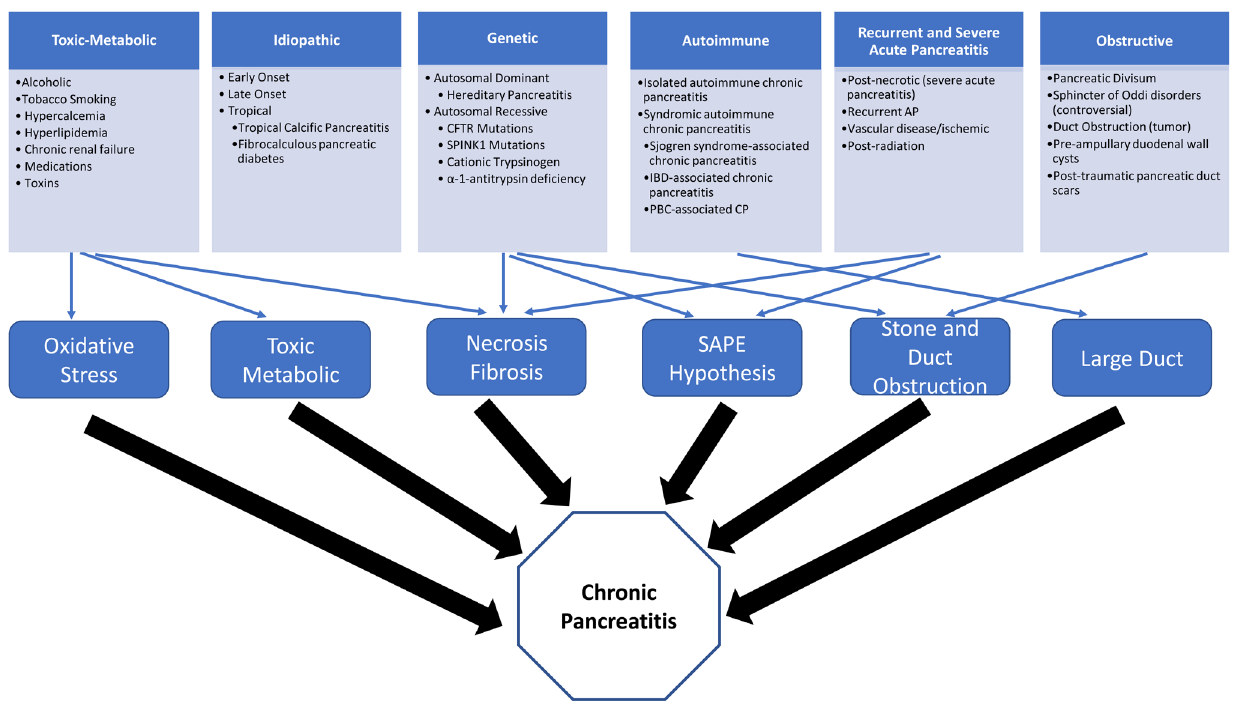
Figure 1. TIGAR-O risk factor classification system. AP, acute pancreatitis; CFTR, cystic fibrosis transmembrane conductance regulator; CP, chronic pancreatitis; IBD, inflammatory bowel disease; PBC, primary biliary cirrhosis; SAPE, sentinel acute pancreatitis event; SPINK1, serine protease inhibitor kazal-type 1; TIGAR-O, Toxic-Metabolic, Idiopathic, Genetic, Autoimmune, Recurrent and Severe Acute Pancreatitis, Obstructive. Adapted from 11